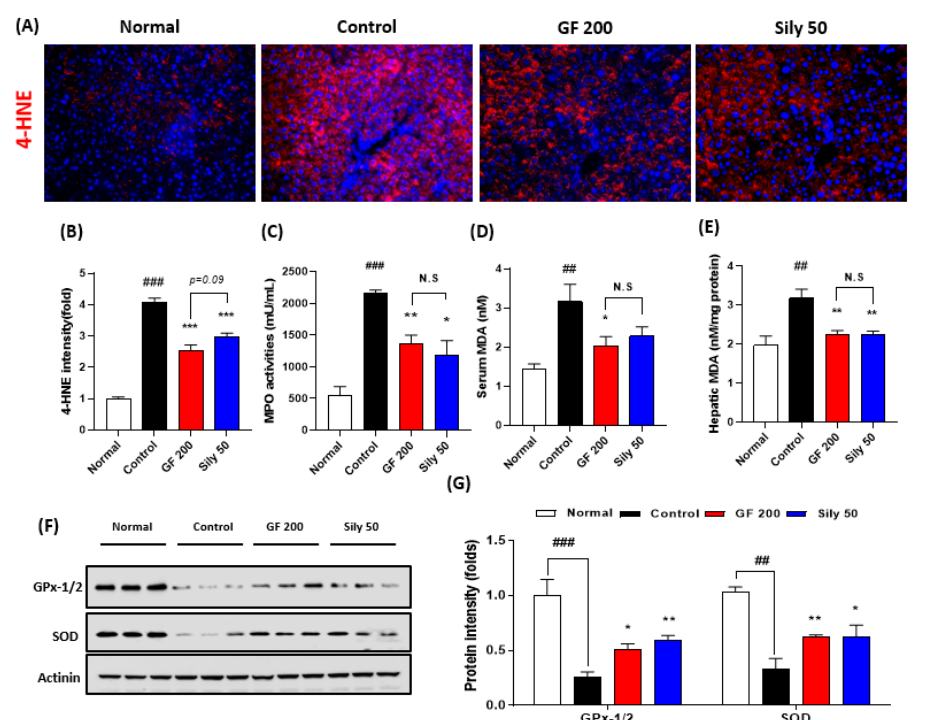
Figure 2. Antioxidant effects of GF on the TAA-induced hepatic tissue oxidation. ( A ) IF analysis against 4-HNE and ( B ) quantification analysis. ( C ) MPO activities in the serum level. ( D ) Serum MDA and ( E ) hepatic MDA levels. ( F ) Western blot analysis of GPx-1/2 and SOD in hepatic protein levels. ( G ) Quantification analysis of GPx-1/2 and SOD. Data were expressed mean ± SEM ( n = 9 for each group). N.S, not significant, ## p < 0.01 and ### p < 0.001 for Normal vs. Control; * p < 0.05, ** p < 0.01, and *** p < 0.001 for Control vs. GF 200 or Sily 50. Images were captured by fluorescence filter equipped with microscope condition (100- or 400-× magnifications).